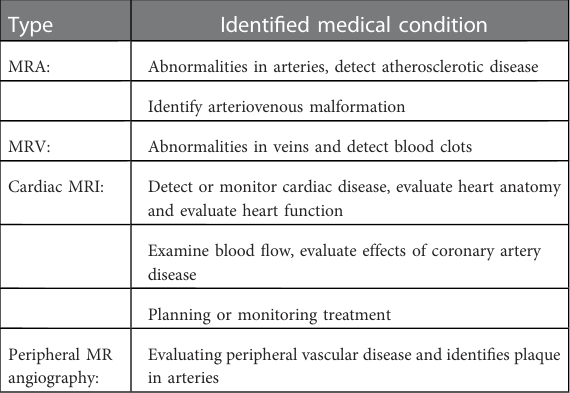
TABLE 2 Types of MRI scanning technologies and the identi fi ed medical condition.